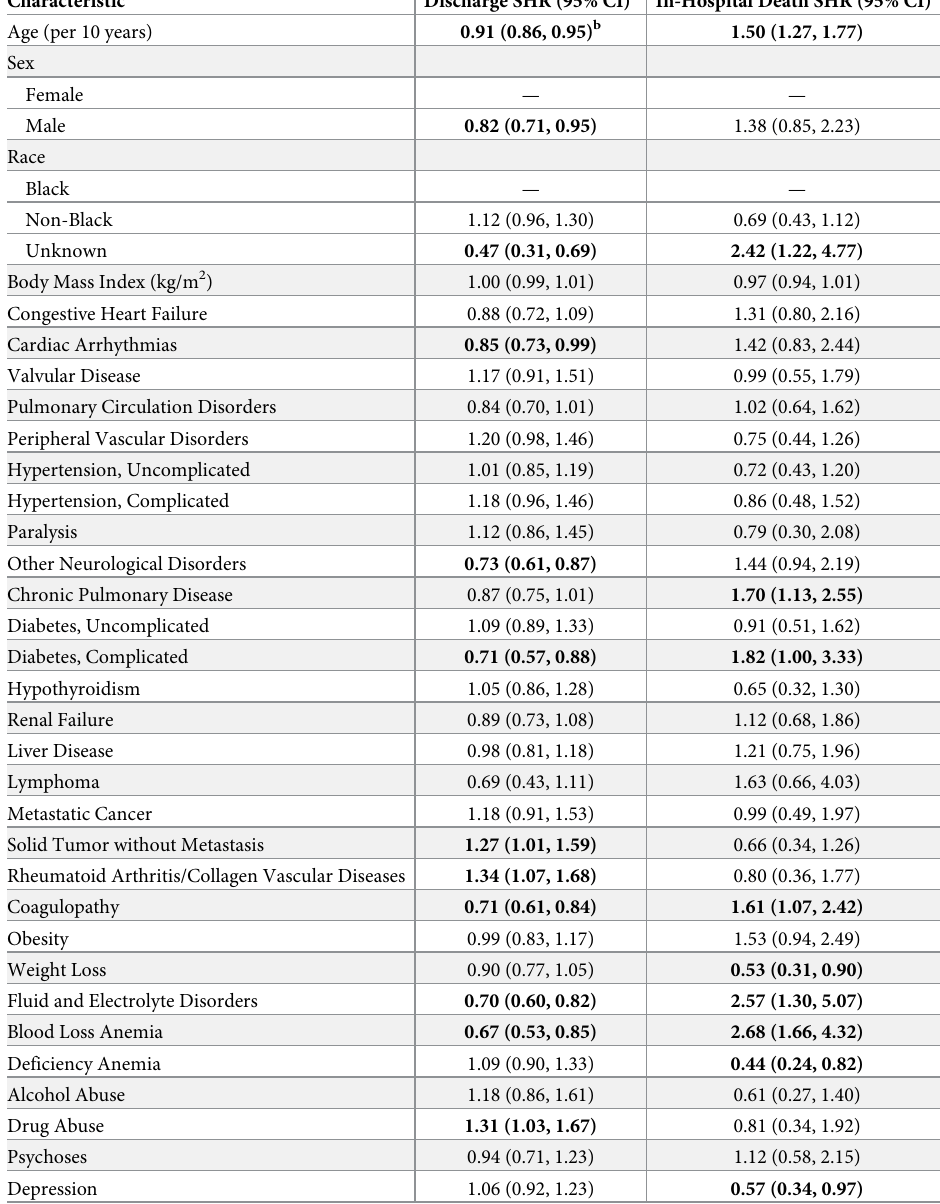
a SHR = Subdistribution Hazard Ratio, CI = Confidence Interval b Bold values indicate statistical